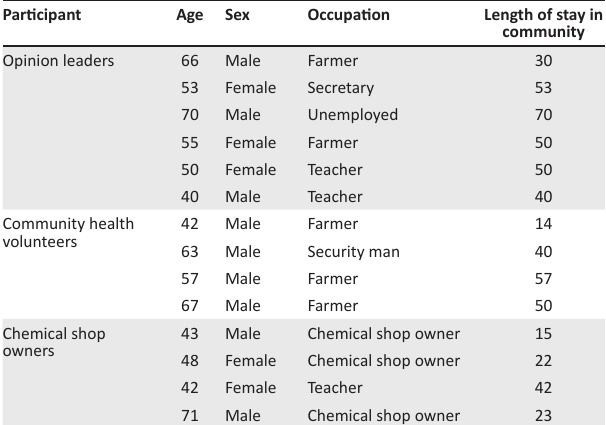
TABLE 3: Background characteristics of in-depth interview participants.